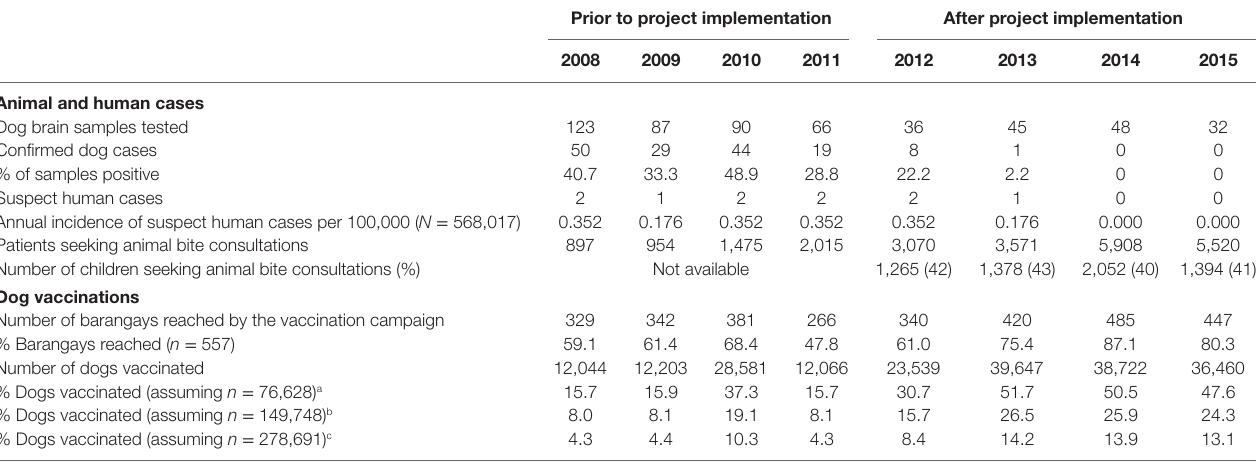
TaBle 2 | indicators of animal and human rabies risks over the project